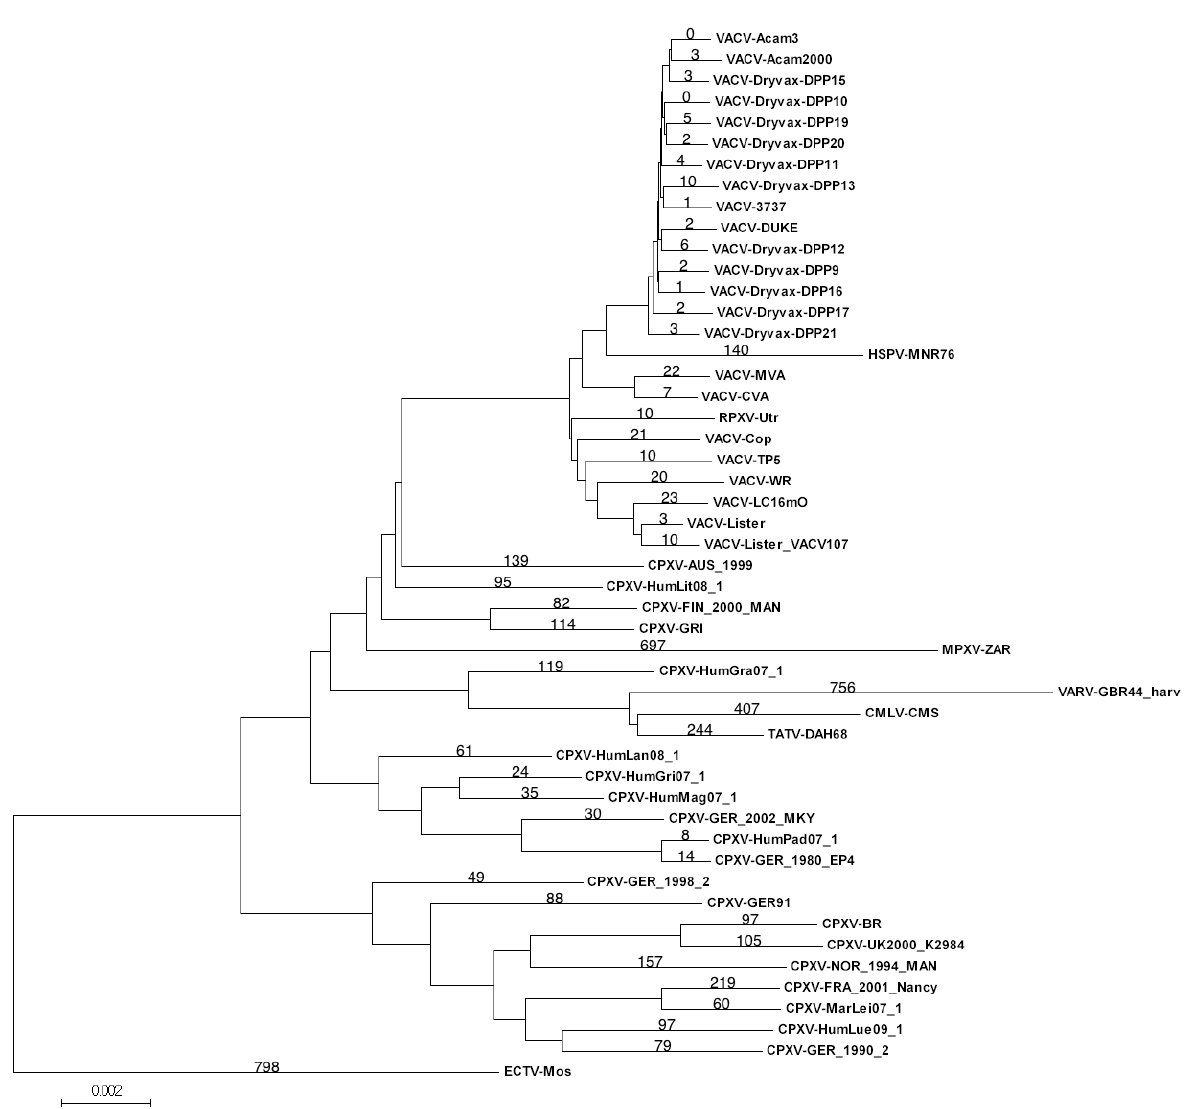
Figure 1. Orthopoxvirus phylogenetic tree. A Neighbor-joining tree was created based on the MaximumComposite Likeihood method with 1000 bootstrap replicates. All bootstrap values were >90 except those associated with vaccinia virus (VACV). Numbers on branches indicate the number of unique SNPs associated with virus core